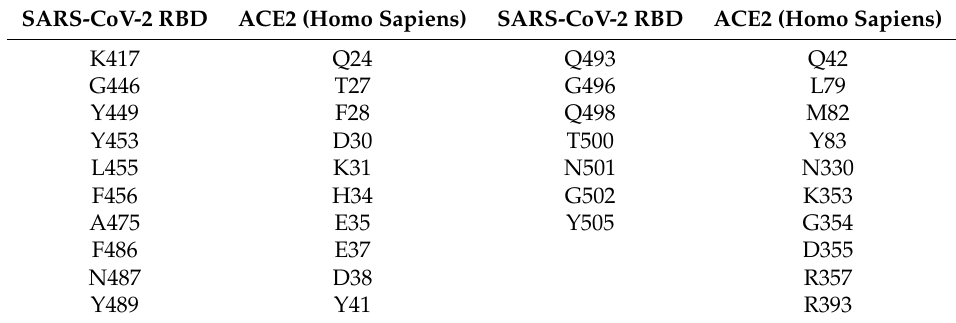
Table 3. Contact residues of RBD spike protein of SARS-CoV-2 and Homo sapiens